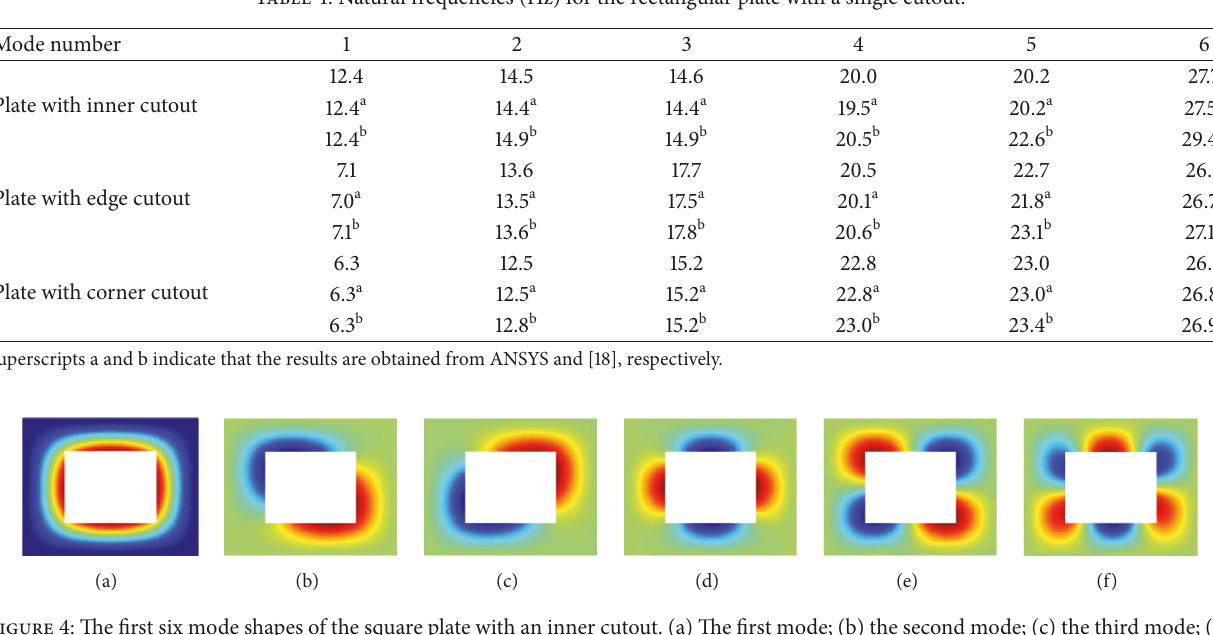
Table 4: Natural frequencies (Hz) for the rectangular plate with a single cutout.